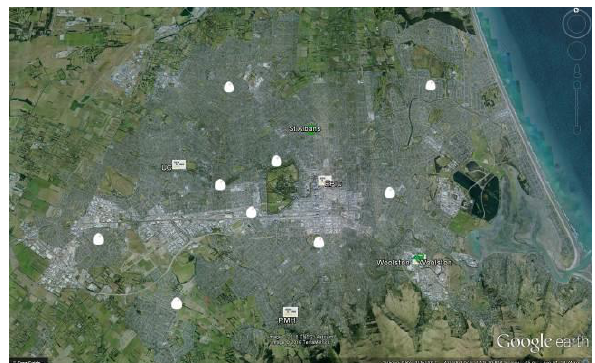
Figure 4. Sensors setup locations proposal in Christchurch ( green sign – ECAN sites; white rectangle – high quality dust motes; white eggs – AQEggs) 2.1.1